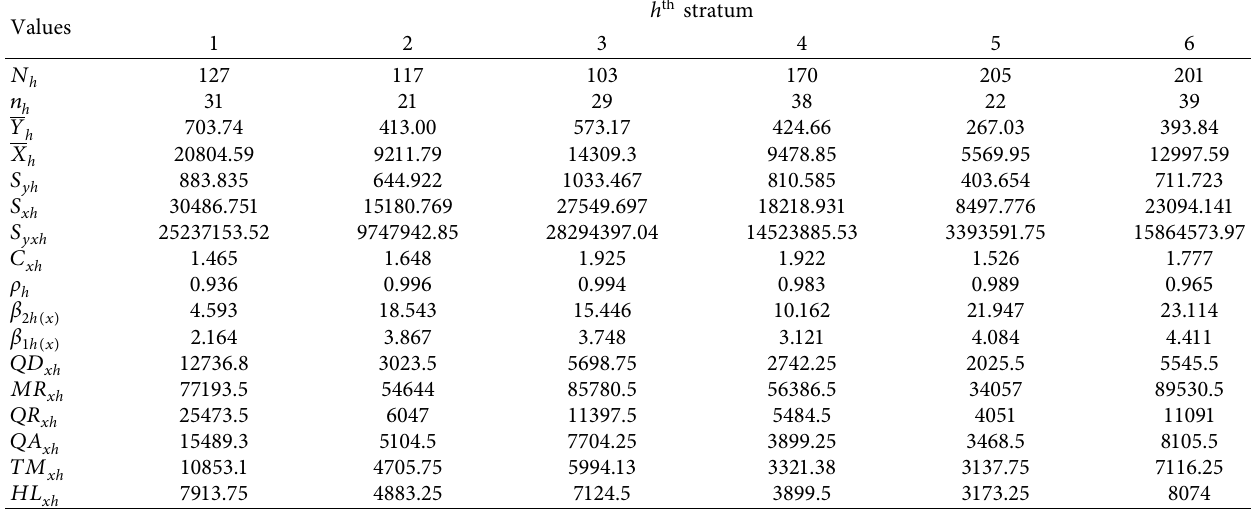
Table 2: Data statistics.